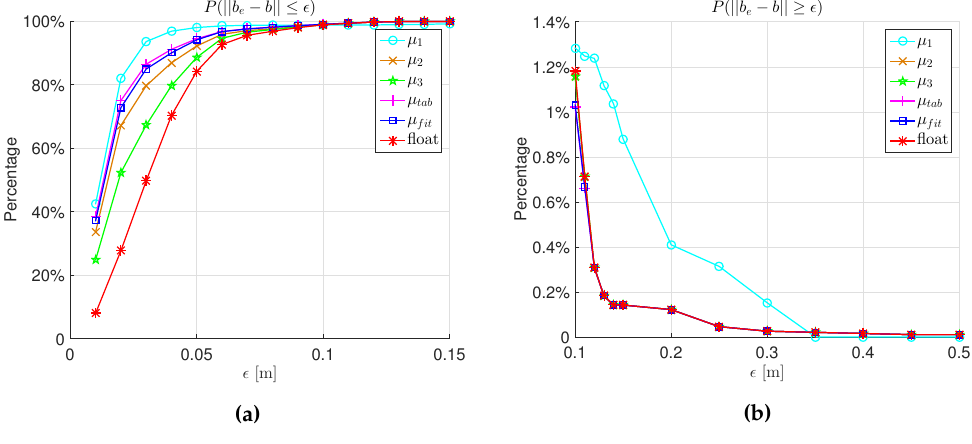
Figure 9. The probability of || b e − b || ≤ (cid:101) and || b e − b || ≥ (cid:101) for the fixed solution with different µ and the float solution. ( a ) P ( || b e − b || ≤ (cid:101) ) ; ( b ) P ( || b e − b || ≥ (cid:101) )